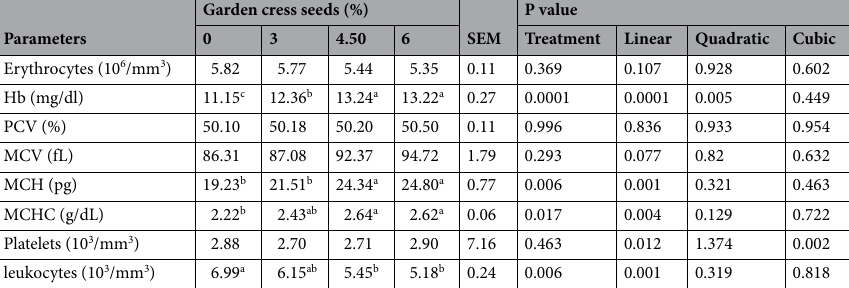
Table 5. Effect of dietary levels of garden cress seeds on haematological parameter of doe rabbits. Hb haemoglobin, PCV packed cell volume, MCV mean corpuscular volume, MCH mean